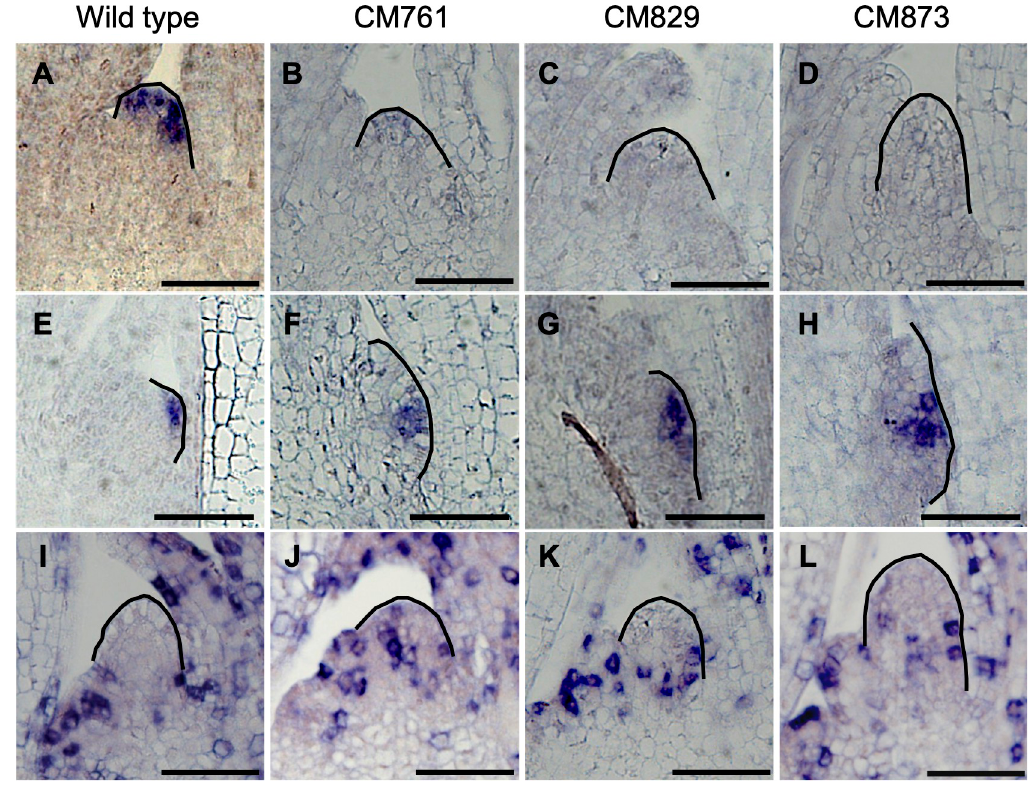
Fig 4. FON2 and histone H4 expression in meristems of wild type and mutants. (A–H) FON2 expression (A–D) in SAM and (E–H) axillary meristem in the early vegetative phase of (A, E) wild type, (B, F) CM761, (C, G) CM829, and (D, H) CM873. (I– L) Histone H4 expression in SAM in the early vegetative phase of (I) wild type, (J) CM761, (K) CM829, and (L) CM873. Meristems are outlined. Scale bars: 50 μ m.